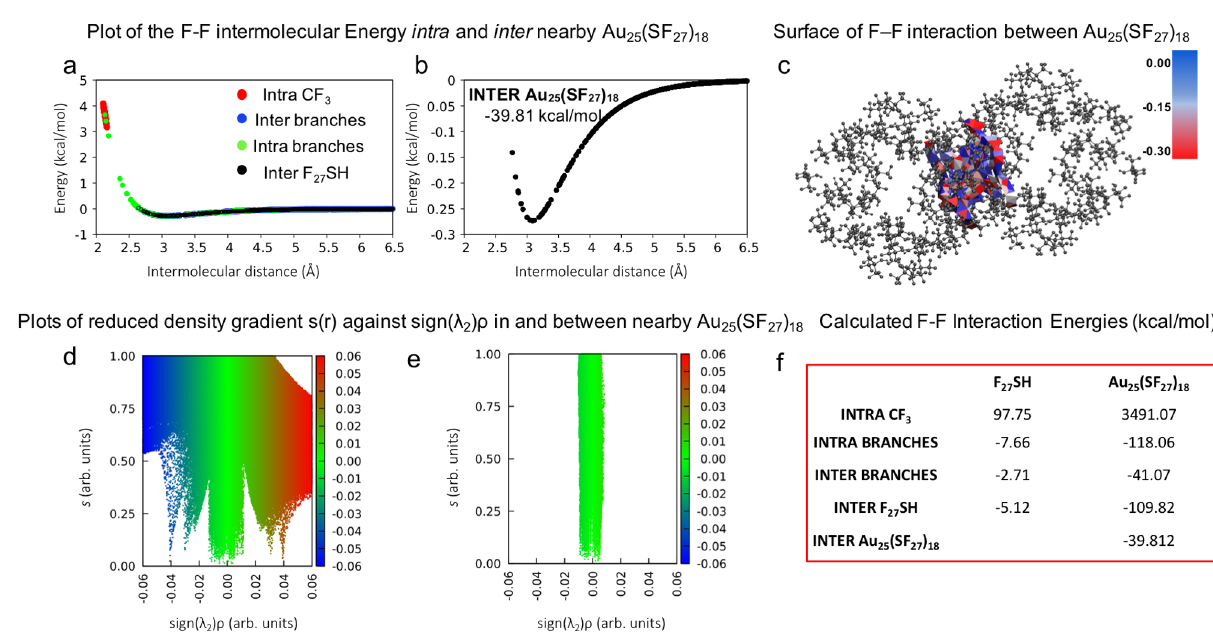
Fig. 5 DFT characterization of F···F interactions in the [Au 25 (SF 27 ) 18 ] 0 crystal structure. a , b F···F Intermolecular interaction energy calculated at M062x/ aug-cc-pvtz level of theory with GD3 Grimme ’ s empirical dispersion corrections as a function of intra- and inter -cluster F···F distances between two cluster F 27 S- ligands. Color code: red, intra -CF 3 ; green, F···F intra -branches; blue, F···F inter -branches; and black, F···F inter -F 27 S-interactions; the inset text box of b reports the total interaction energy (kcal/mol) for every F···F interacting cluster pair; c surface representation of F···F intermolecular interaction energy in the inter -cluster region; color code: − 0.30 (red) < − 0.15 (white) < 0.00 (blue); d non-covalent interaction map visualized by using promolecular densities showing intra- and inter- non-covalent interacting regions of two nearby clusters. The reduced density gradient is plotted versus the sign of the second density Hessian eigenvalue multiplied by the density itself (sign( λ 2 ) ρ ); color code: blue for attractive (negative values of sign( λ 2 ) ρ ) interactions, red for repulsive (positive values of sign( λ 2 ) ρ ) interactions and green for weak van der Waals interactions (sign( λ 2 ) ρ close to zero); e magni fi cation of an area of d for inter -cluster F···F interactions; f table of total interacting energy values (kcal/mol) calculated for every F···F interacting